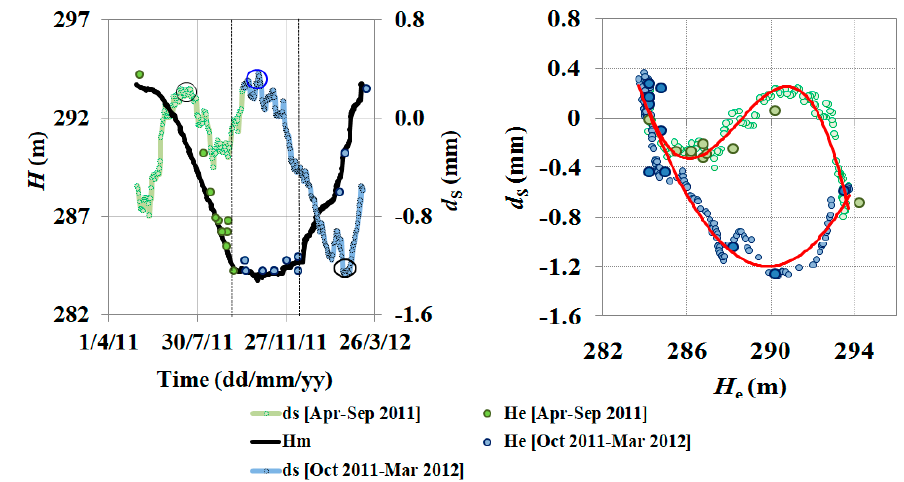
Figure 14. On the left panel: Time behavior of the water level from measurements in situ ( H m , black line) and visual matching ( H e , big circles) during the emptying phase until the minimum (in green) and filling phase (in blue) from the minimum (primary y-axis,) and GNSS time averaged displacements ( d S ) (green and blue lines, secondary y-axis). On the right panel, H e , and H m , vs. d S . during the emptying (green circles) and filling (blue circles) phase, over-imposed two interpolation curves (red continuous lines). Indeed, a maximum dam displacement occurs in the middle of July 2011 (black circle) when daily average air temperature and water surface temperature reached their maxima values (30.5 ◦ C on the 15 and 26.2 ◦ C on the 18, respectively); while, a minimum dam displacement occurs during the second decade of February 2012 (black circle) when air and water temperatures reached their minima values (2.5 ◦ C on the 11 and 8.2 ◦ C on the 16,